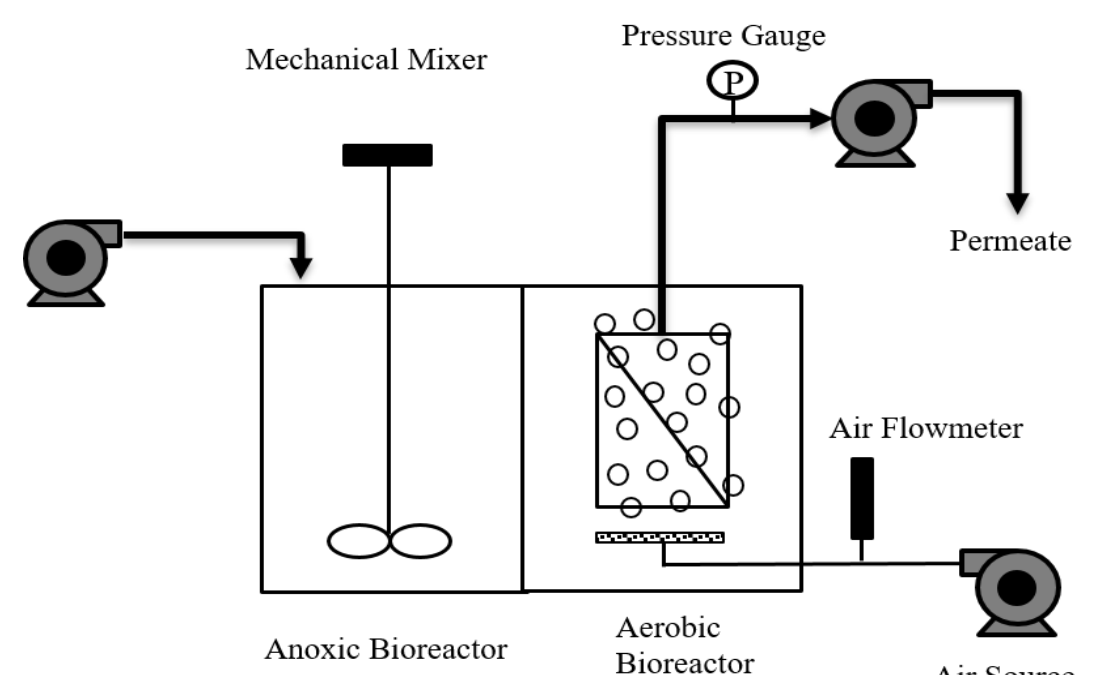
Figure 1. The laboratory-scale membrane bioreactor consisted of anoxic and aerobic membrane filtration tanks. Recirculation of the mixed liquor suspended solids between the anoxic and aerobic tanks ensured nitrification and denitrification at the two different redox potentials.